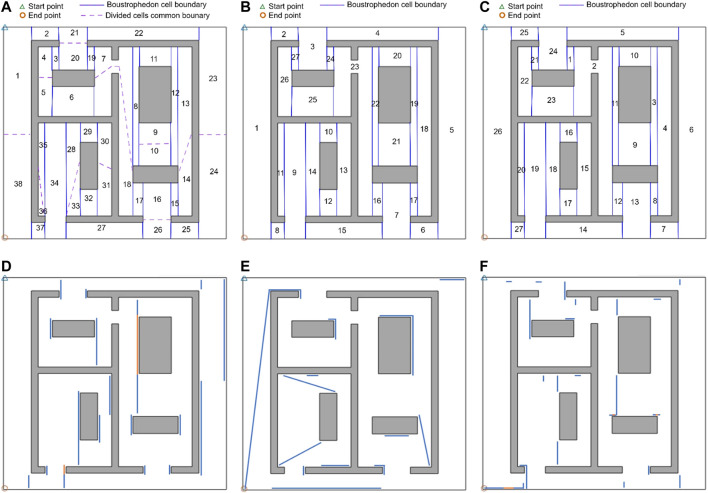
The cell coverage sequence by: (A) the CPP technique proposed in (Xu et al., 2014), (B) the CPP technique proposed in (Tung and Liu, 2019), and (C) the proposed CPP technique based on the graph representation of environment The extra travelled distances (overlaps) in the generated coverage path by: (D) the CPP technique given in (Xu et al., 2014), (E) the CPP technique proposed in (Tung and Liu, 2019), and (F) the proposed CPP technique based on the graph representation of environment. The overlapping parts of the path are shown by solid blue lines. The solid orange lines.